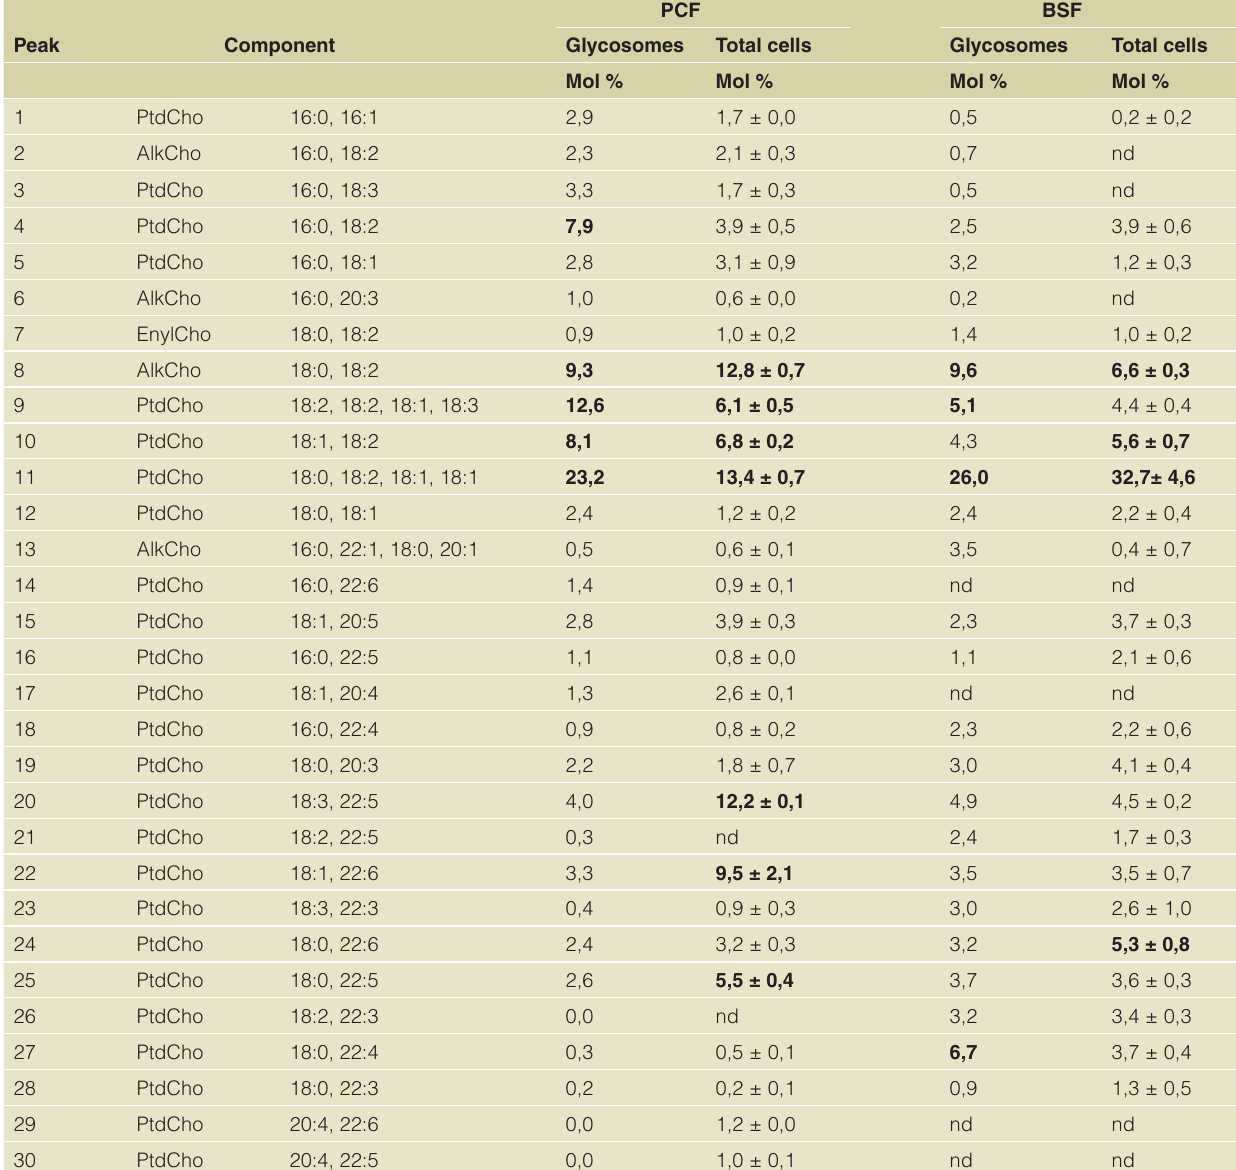
Table 3. Phosphatidylcholine composition of procyclic-form and bloodstream-form T. brucei total cells and glycosomes.